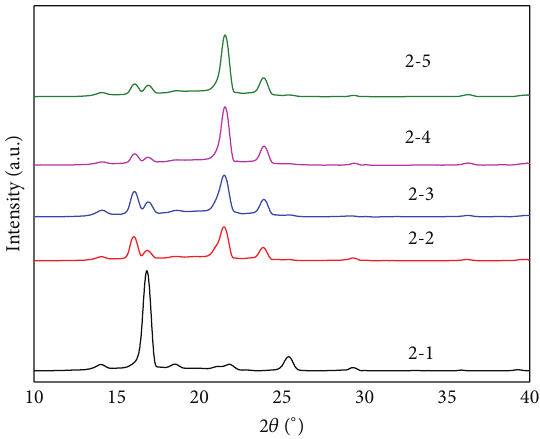
Figure 2: WAXD spectra of PP with the different WBG